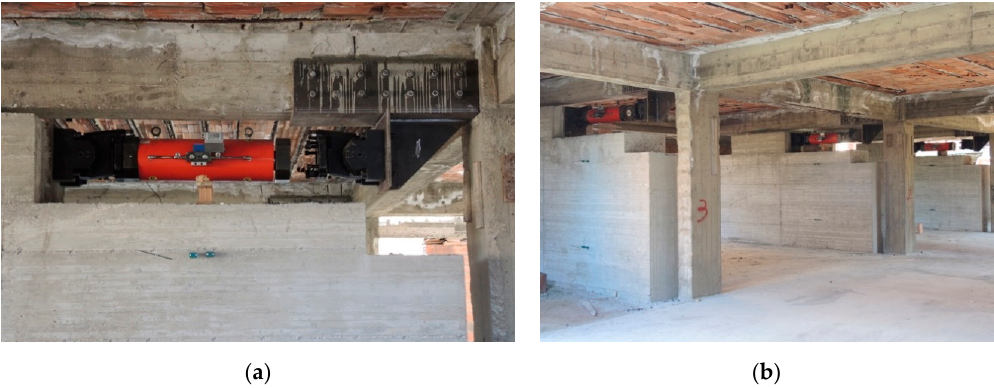
Figure 8. Steel element connections for the actuators: On the reaction wall ( a ) and on the frame first floor beam ( b ).